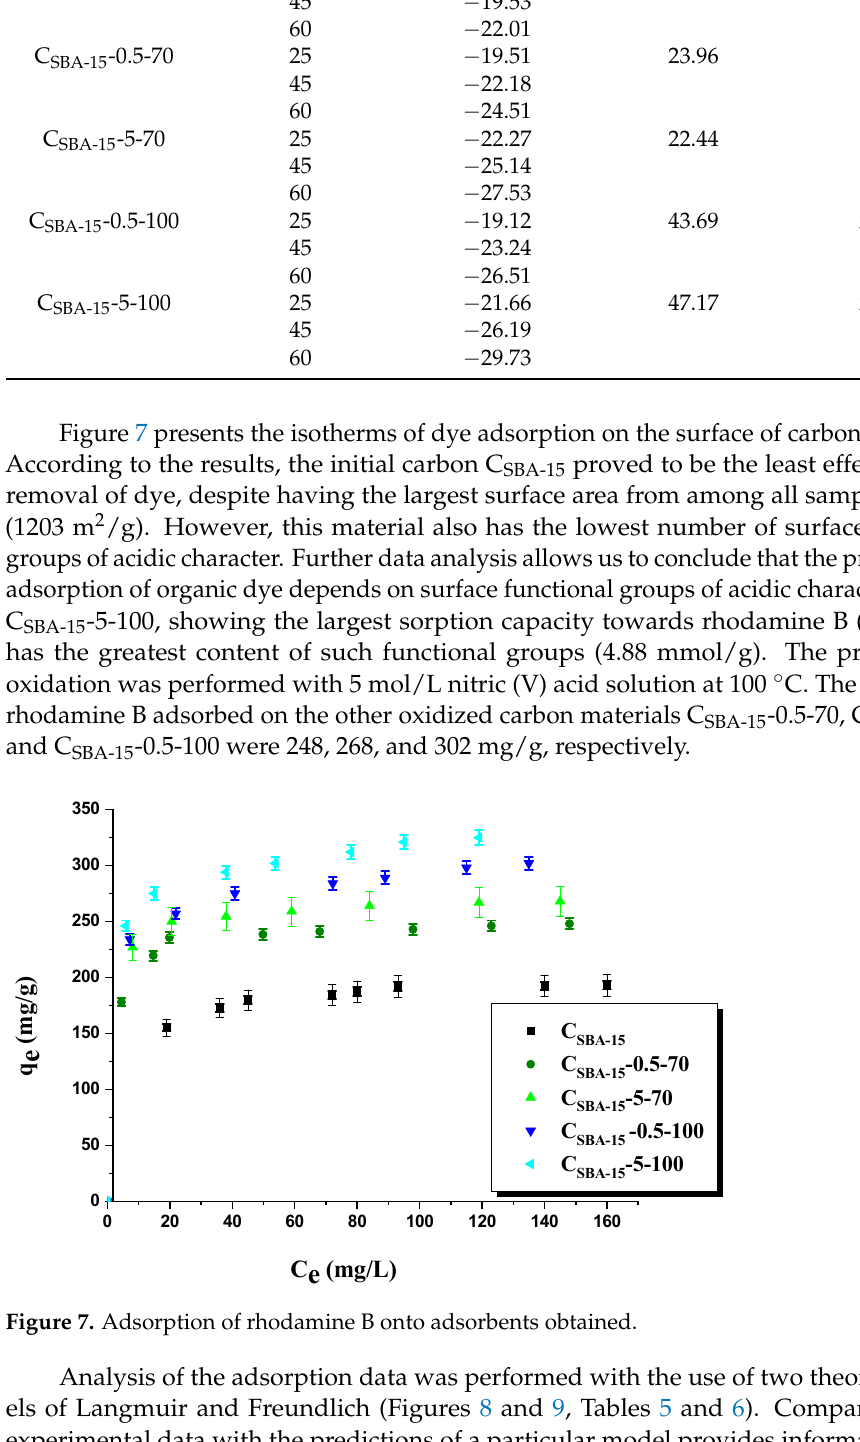
Figure 8. Linear fitting of rhodamine B adsorption isotherms onto carbon adsorbents to Langmuir ( A ) and Freundlich ( B ) models.